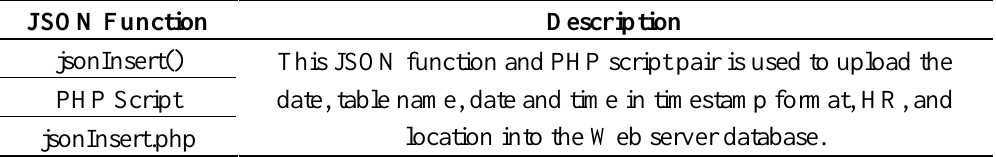
Table 2. Description of the JSON function and PHP script